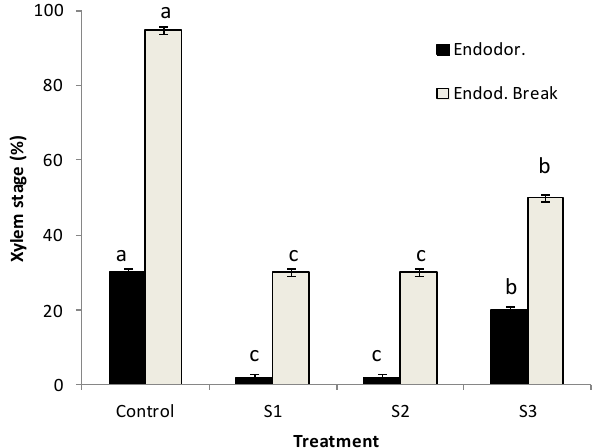
Figure 6. Percentage of xylem vessel differentiation (Stage 2 and 3) in flower bud axis of apricot cultivar ‘Portici’ after water stress treatments for 30 d imposed in June (S1), July (S2) and October (S3). Data are referred as flower buds at endodormancy (November–January) and break of endodormancy phases (February). Bars represent mean values ±SD. Different letters within each dormancy phase indicate significant differences at P ≤ 0.05.